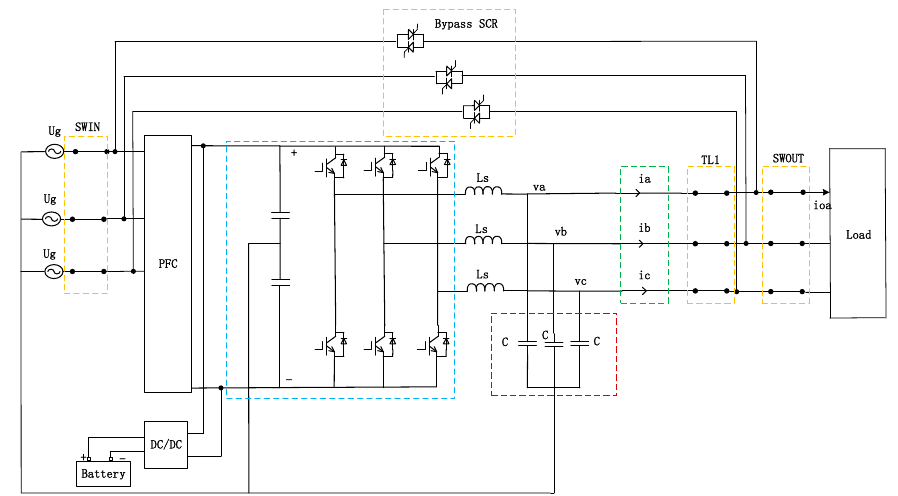
Figure 1. Topology of on-line UPS.